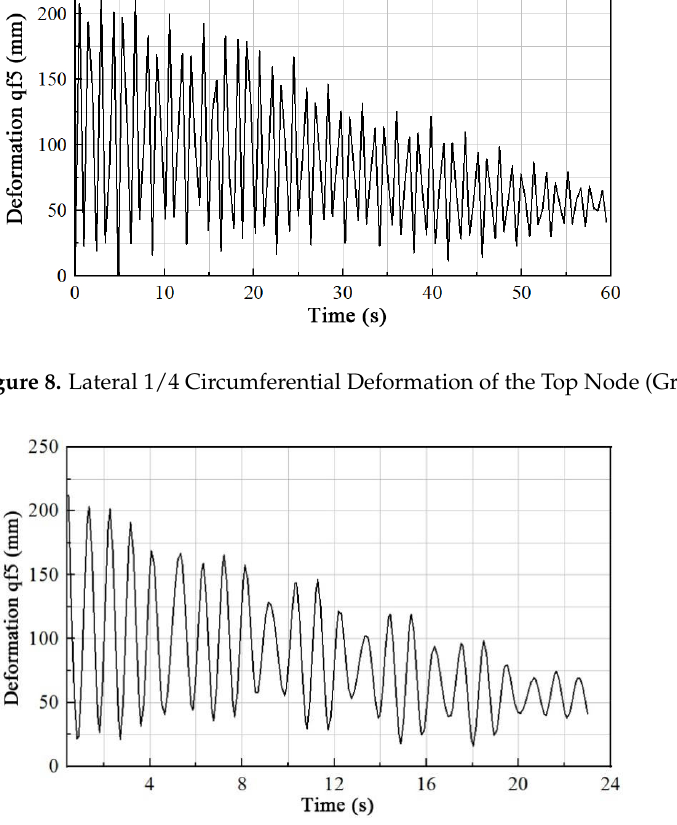
Figure 9. Lateral 1/4 Circumferential Deformation of the Top Node (Group #3) .